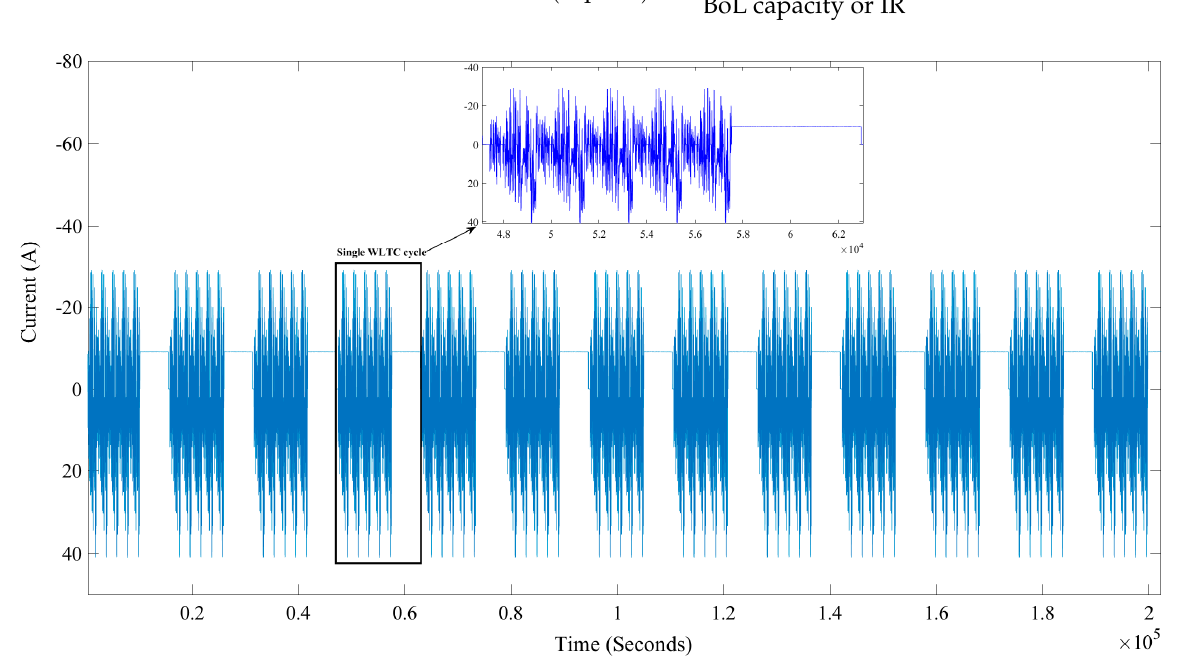
Figure 1. The dynamic and realistic continuous WLTC current profile.